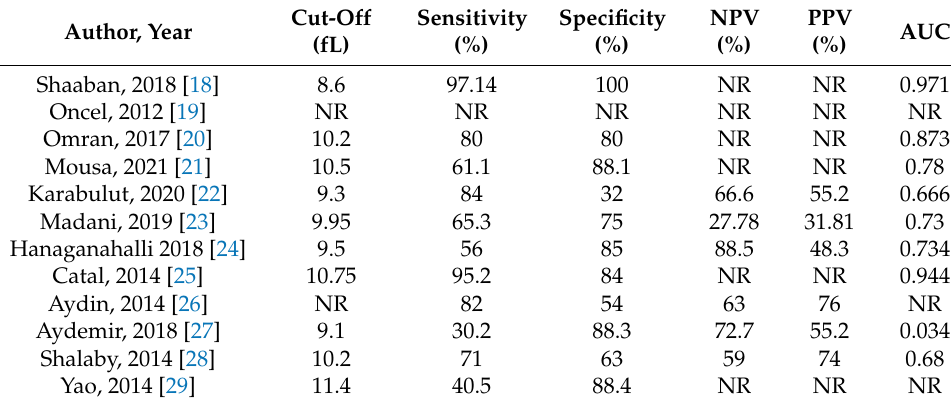
Table 2. Diagnosis accuracy between studies.